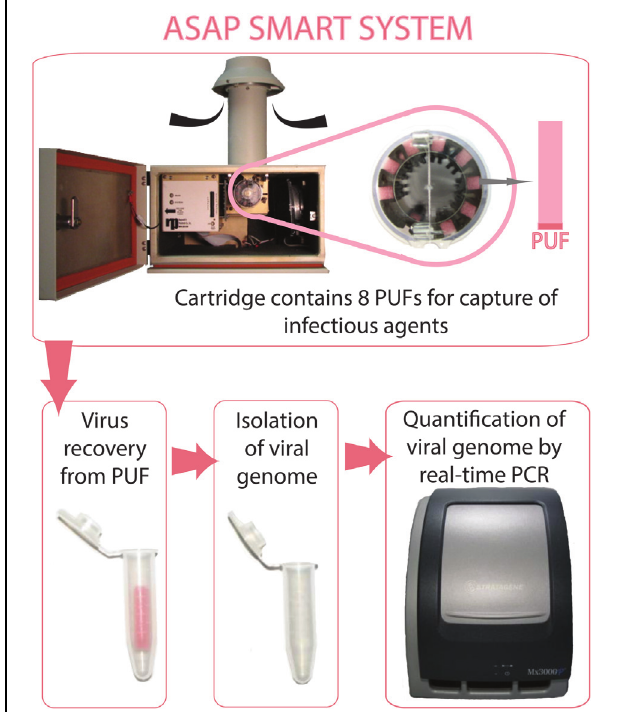
FIGURE 1 | Functioning of Airborne Sample Analysis Platform (ASAP) System. Bioaerosols contained in the ambient air are sucked in through the inlet of the ASAP bio-sampler and deposited on a strip of polyurethane foam (PUF) contained in the Integrated Bio Aerosol Sampling System (iBASS) cartridge. The individual polyurethane foam (PUF) strips are then processed for pathogen isolation and nucleic acid extraction. Quantitative polymerase chain reaction (qPCR) is set up for specific detection of the